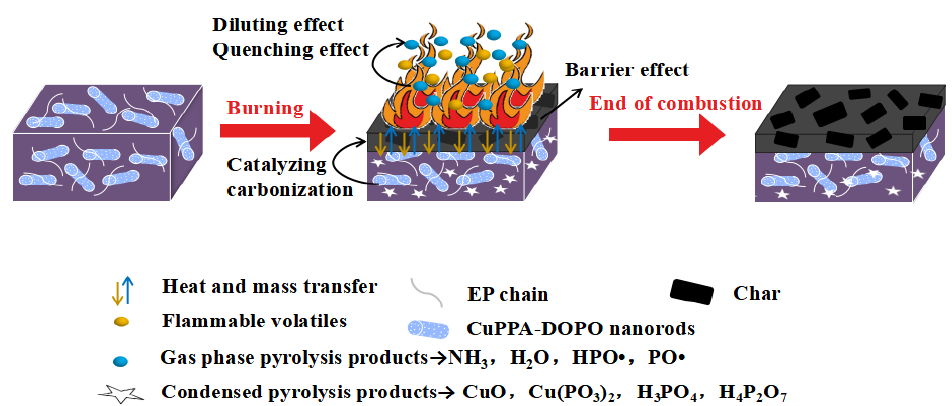
Figure 7. Flame-retardance mechanism diagram of EP/CuPPA-DOPO composites.